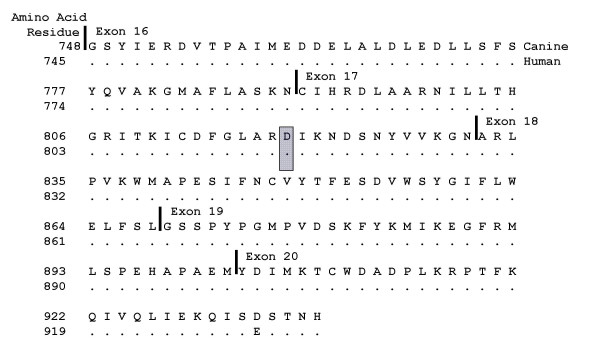
Amino acid alignment of the kinase domain (exons 16–20) of canine and human KIT. Canine and human amino acid alignments demonstrate a 99.5% identity between the phospho-transferase portion of the kinase domain of these species. Codon 816, which is commonly mutated in human mastocytosis patients (D816V; shaded residue) is also conserved in canine KIT.